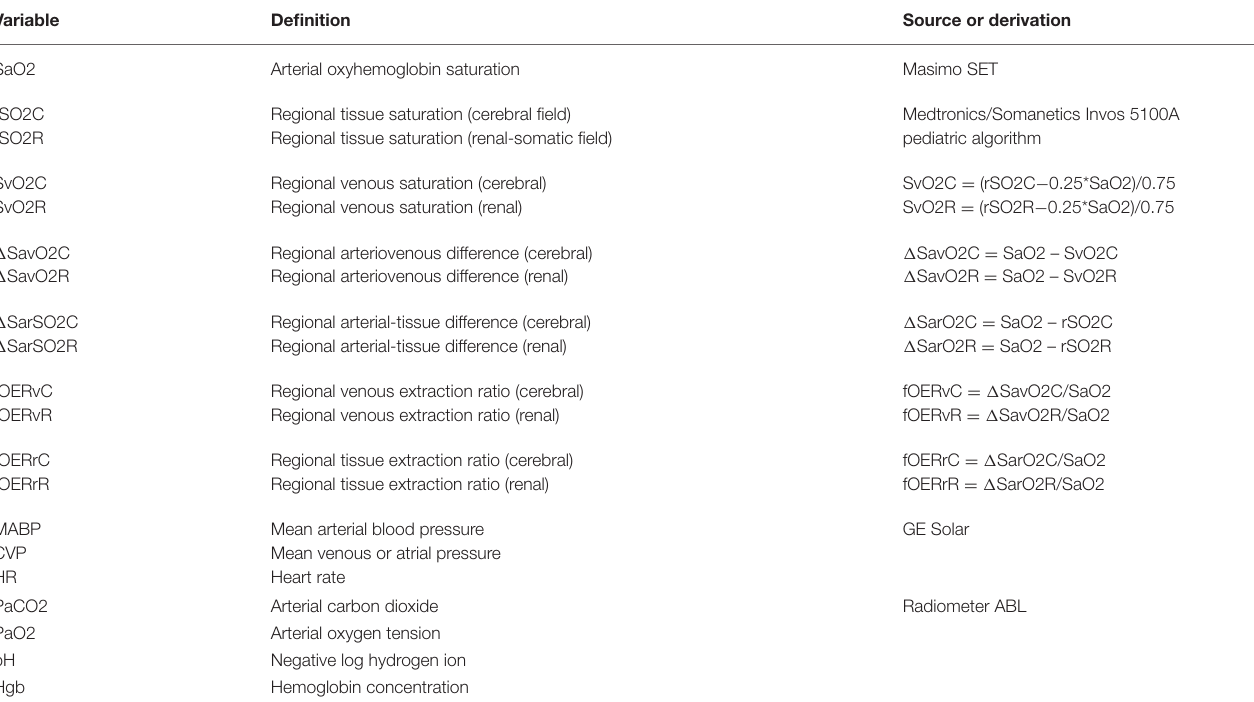
TABLE 1 | Sources and formulae for measured and derived physiologic variables. Variable